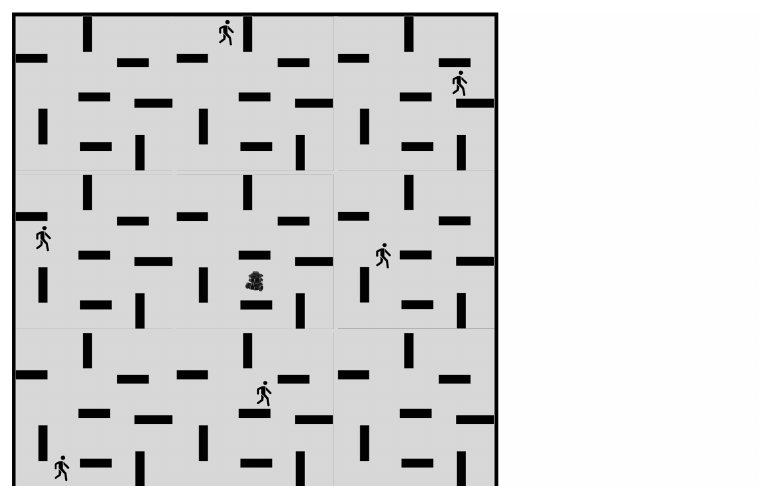
Figure 12. Large-Scale Dynamic